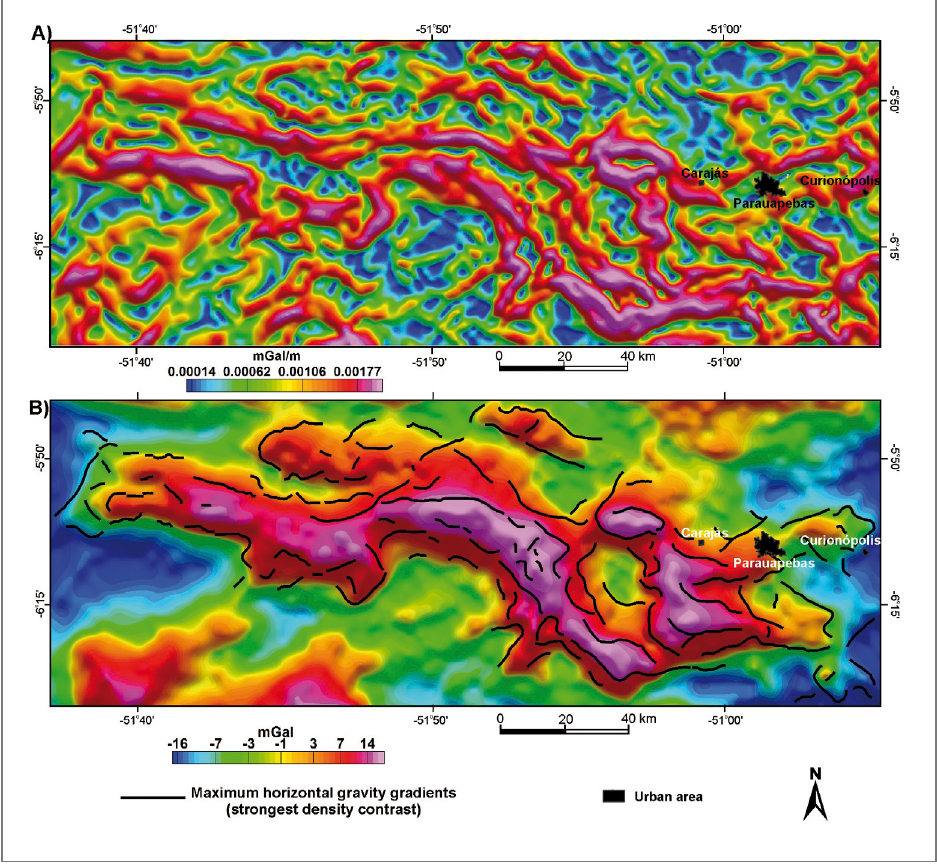
Figure 4 - A) Horizontal gravity gradients of the Bouguer anomalies; B) Bouguer gravity anomalies with first order trend removed and superposition of maximum horizontal gradient (black